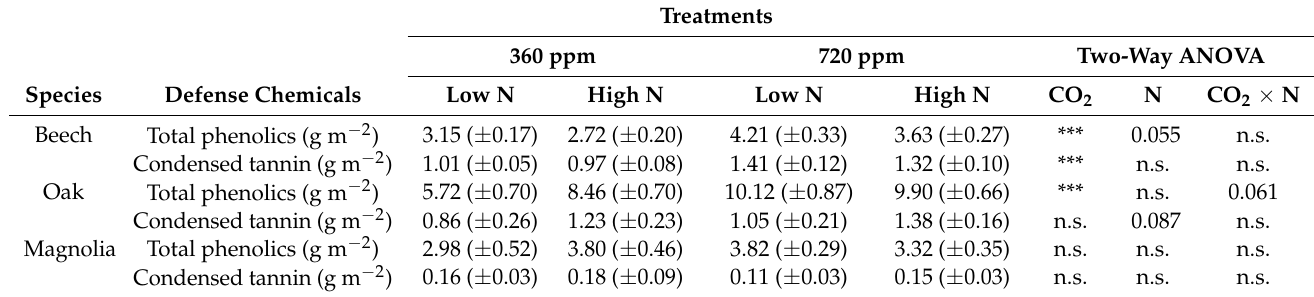
Table 1. The amounts of total phenolics and condensed tannin per area in the leaves of three tree species grown in each treatment. Values in parentheses are standard errors of the means. Results of two-way ANOVA are also shown (*** p < 0.001, n.s. p (cid:61) 0.01), n.s.; not significant. Actual p values are shown when 0.05 < p < 0.10.